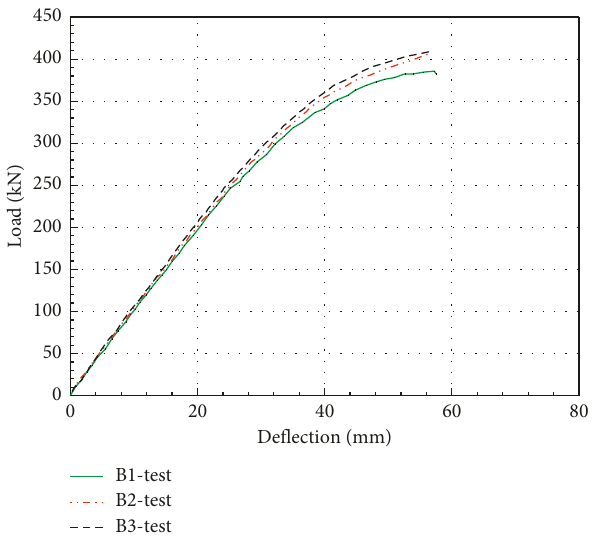
Figure 5: Load-deflection curves.